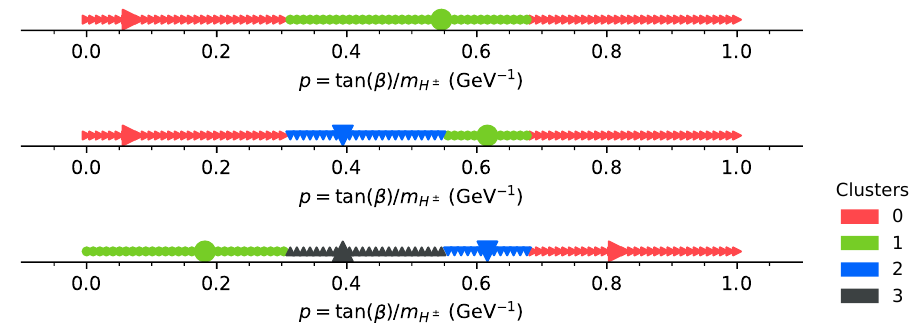
Figure 6 . Clustering of the one-dimensional parameter space p of the observable d(cid:0)( (cid:22) B ! D(cid:28) (cid:0) ( ! ‘ (cid:22) (cid:23) ‘ (cid:23) (cid:28) )(cid:22) (cid:23) (cid:28) ) = d( E ‘ ), with E ‘ denoting the lepton energy. The NP parameter p stems from a two- Higgs-doublet model. The clustering is performed assuming signal yields of 1000, 1800 and 2000 events as well as a relative uncertainty of 1% and leads to a total of two, three and four clusters